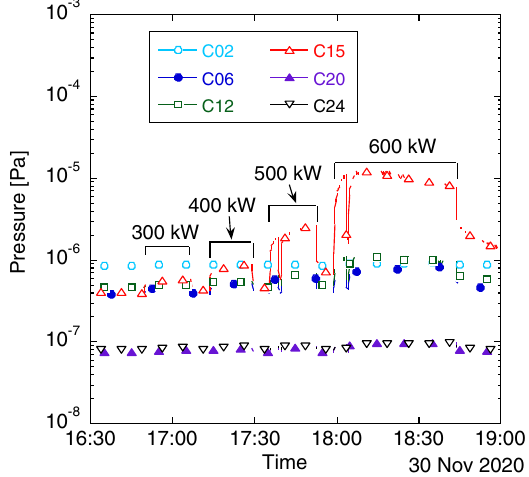
FIG. 28. Pressure measured by the CCGs during the beam operation after the installation of the additional NEG pumps in the second arc section. Other conditions are the same as point G in Fig. 14 [Fig.